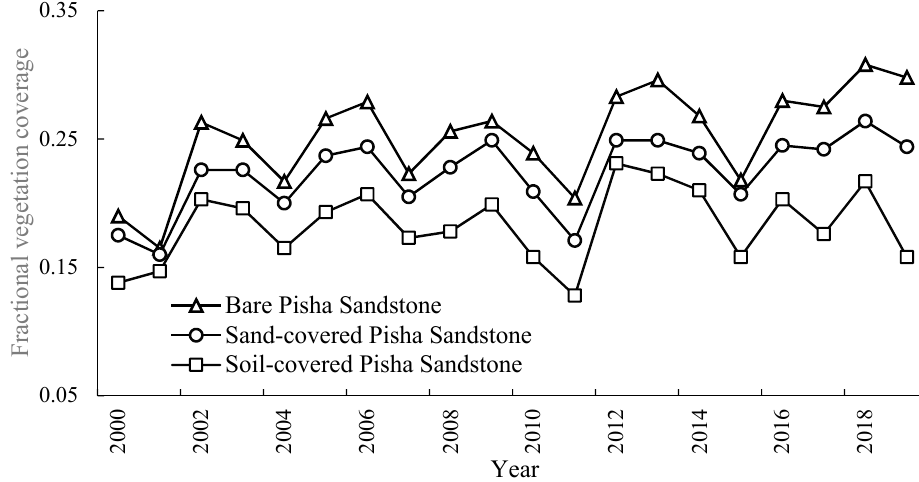
Figure 4. Variations in FVC in the Pisha Sandstone area from 2000 to 2019.